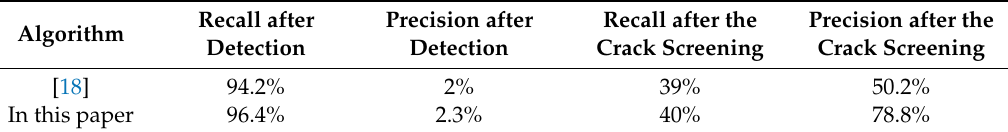
Table 2. Algorithm comparison